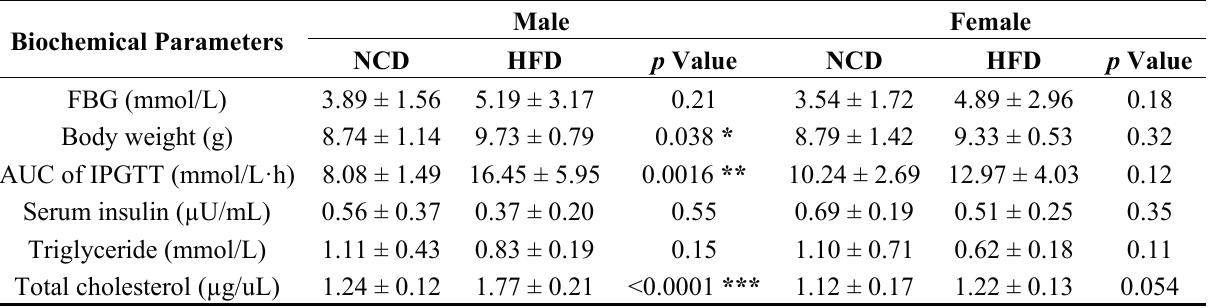
Table 1. The comparison of biochemical parameters of the male and female offspring at weaning in the high-fat diet and normal chow diet groups. Data represented as the mean ± S.D. ( n = 8 per group of male and female). * p < 0.05, ** p < 0.01, *** p < 0.001 vs. the normal chow diet